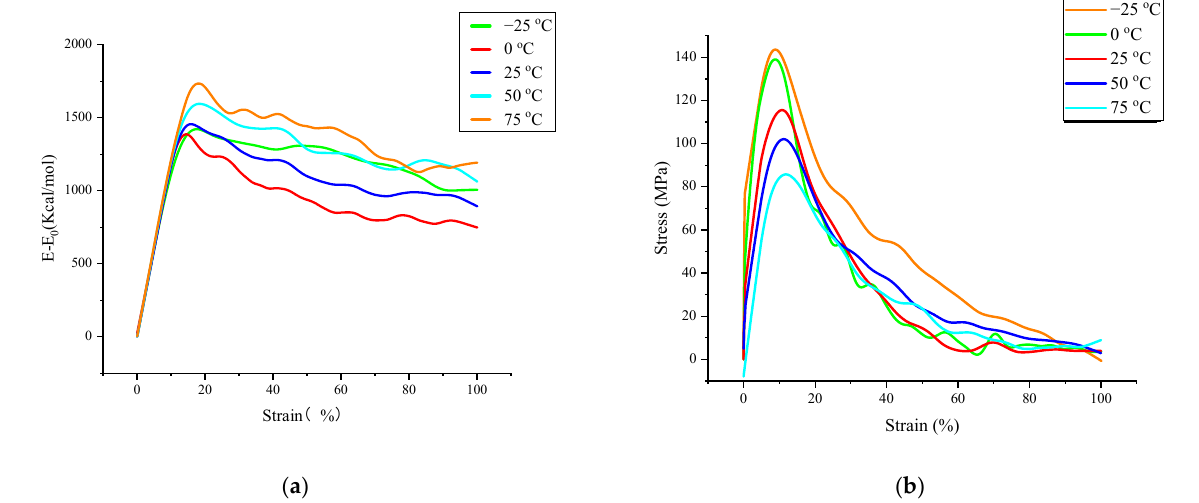
Figure 9. Interaction energy change–strain and stress–strain curves for tensile failure processes under different temperature conditions: ( a ) Interaction energy change–strain curves at different temperatures ( b ) Stress–strain curves at different temperatures.